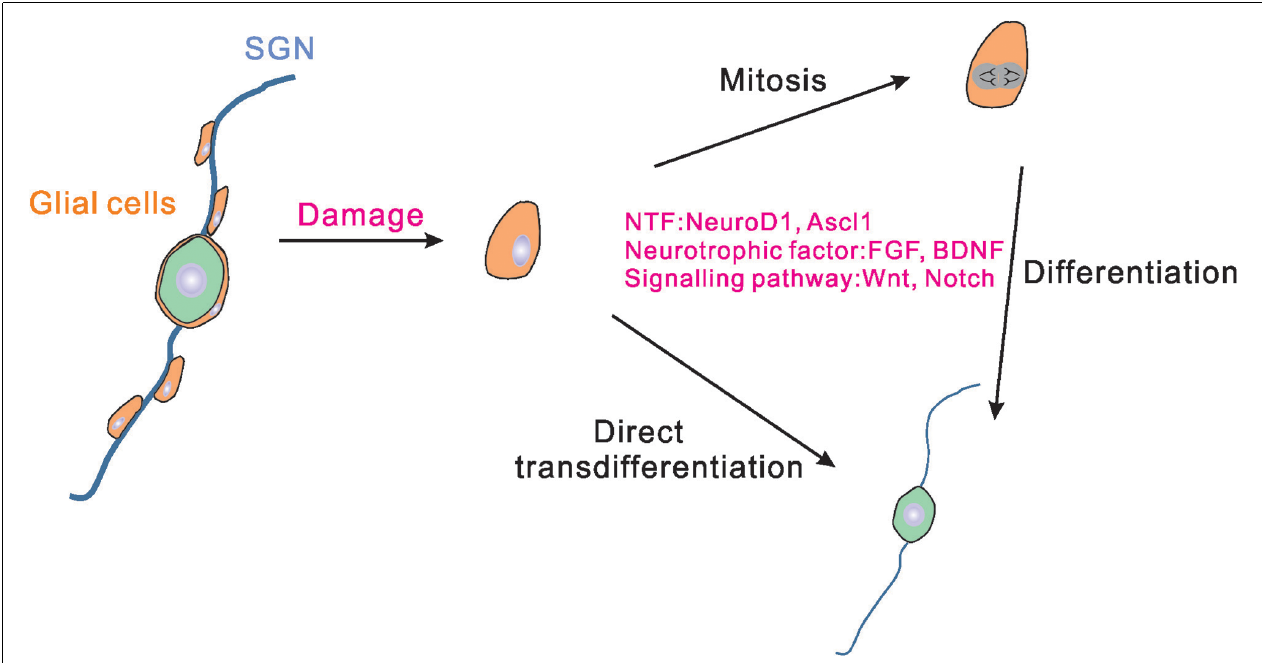
FIGURE 1 | Schematic drawing of the endogenous glial cells regenerating SGNs. In the cochlea, satellite glial cells exist around SGNs. Satellite glial cells may proliferate and differentiate into SGNs when the SGNs are damaged. Some of the glial cells can also be directly transdifferentiated into SGNs. Neurogenic transcription factors, neurotrophic factors, and signal pathways could regulate the process of glial cells proliferation and differentiation. NTF, neurogenic transcription factors; SGNs, spiral ganglion